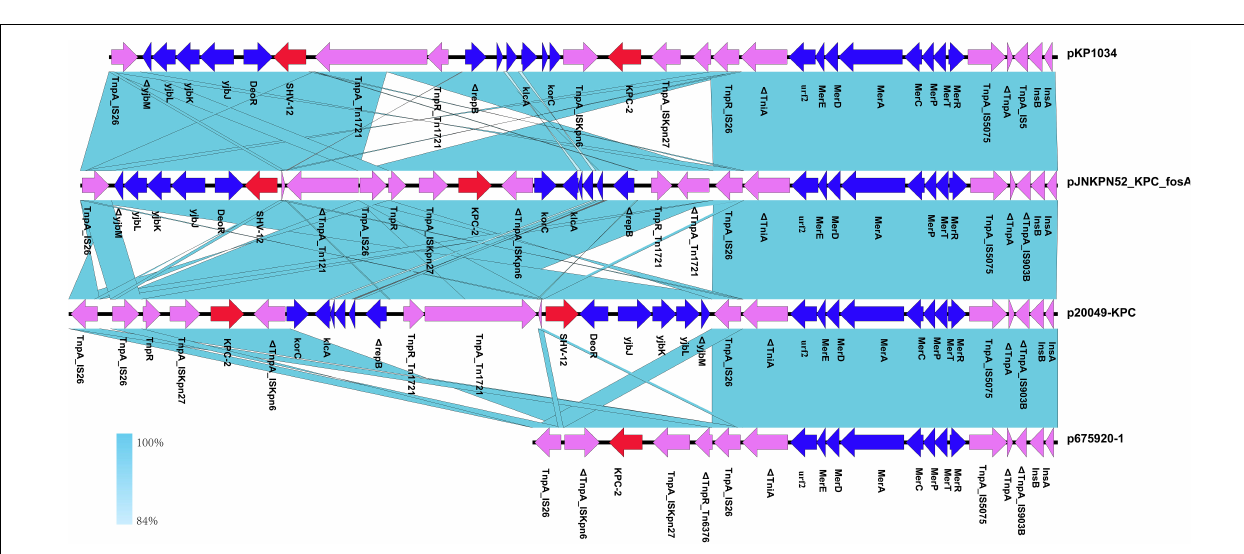
FIGURE 7 | Comparison of genetic context of the bla KPC − 2 region with related